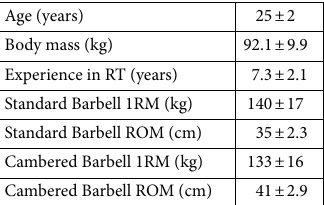
Table 1. Descriptive characteristics of the study participants. RT resistance training, 1RM one repetition maximum, ROM range of motion.